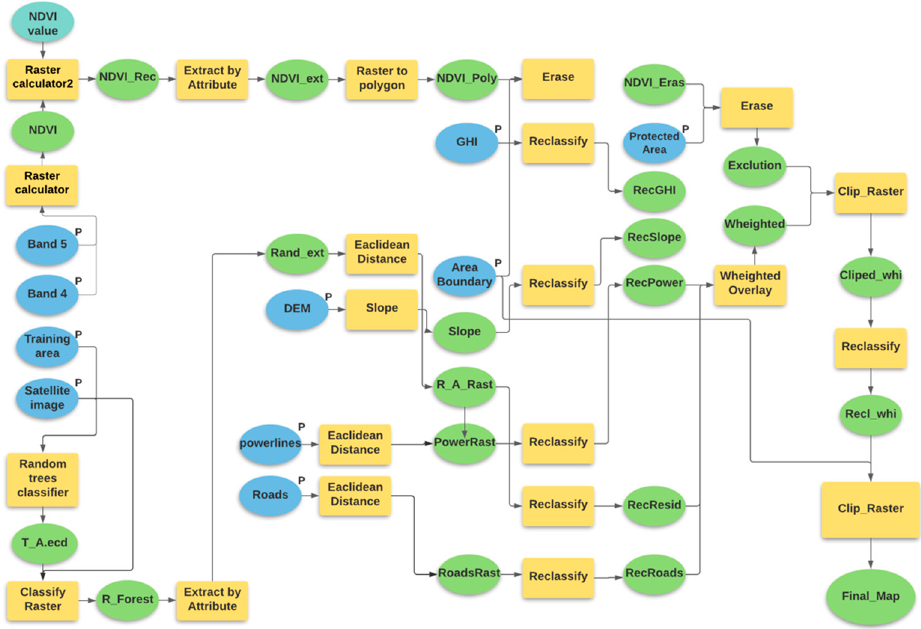
Figure 8. Project model and the parameters of the model using ArcGIS Pro Model builder.